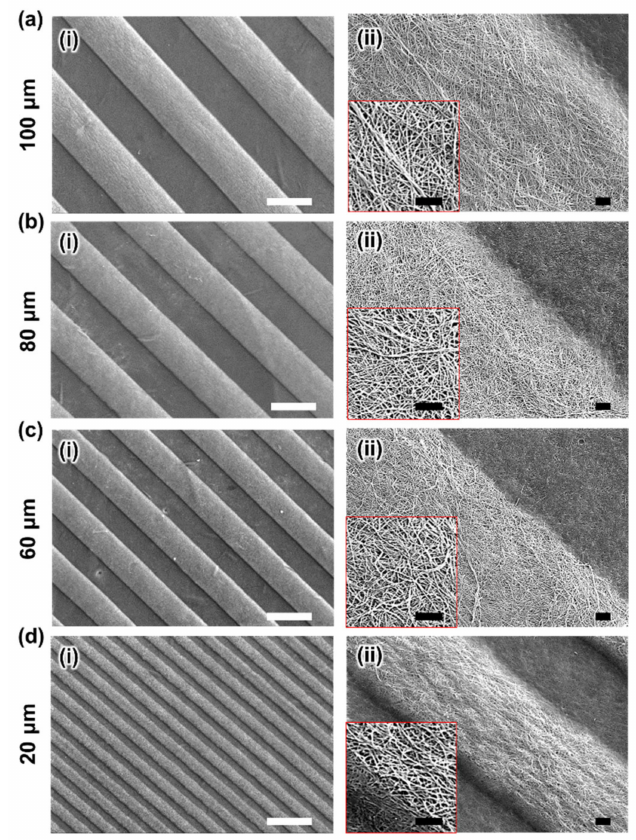
Figure 3. Microstructures of the IPC-CE constructs. SEM images of micro-ridge patterns with di ff erent widths of ( a ) 100, ( b ) 80, ( c ) 60, and ( d ) 20 µ m at ( i ) low and ( ii ) high magnifications. White and black scale bars are 100 and 2 µ m,